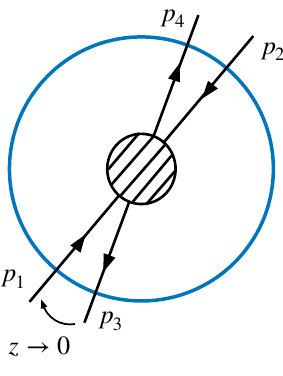
Figure 2 . Eikonal kinematics in which the operators associated with particles 1, 3 and 2, 4 are respectively inserted around antipodal points on the celestial